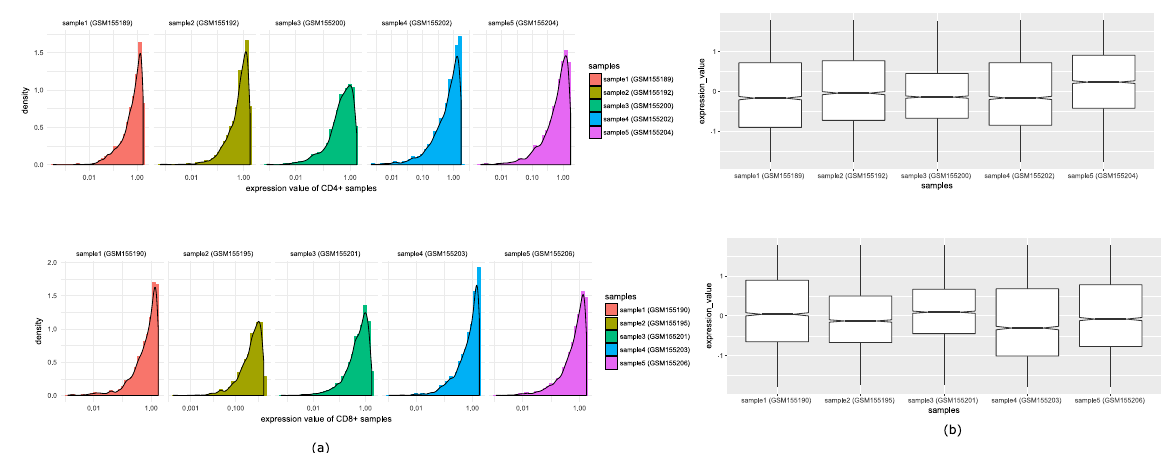
Figure 5. Comparison of expression values of CD4 + and CD8 + samples in chronic stage. Panel (a) shows the distribution of five samples of CD4 + cell (GSM155189, GSM155192, GSM155200, GSM155202 and GSM155204) and five sample of CD8 + cell (GSM155190, GSM155195, GSM155201, GSM155203 and GSM155206). Panel (b) shows the boxplots of the corresponding